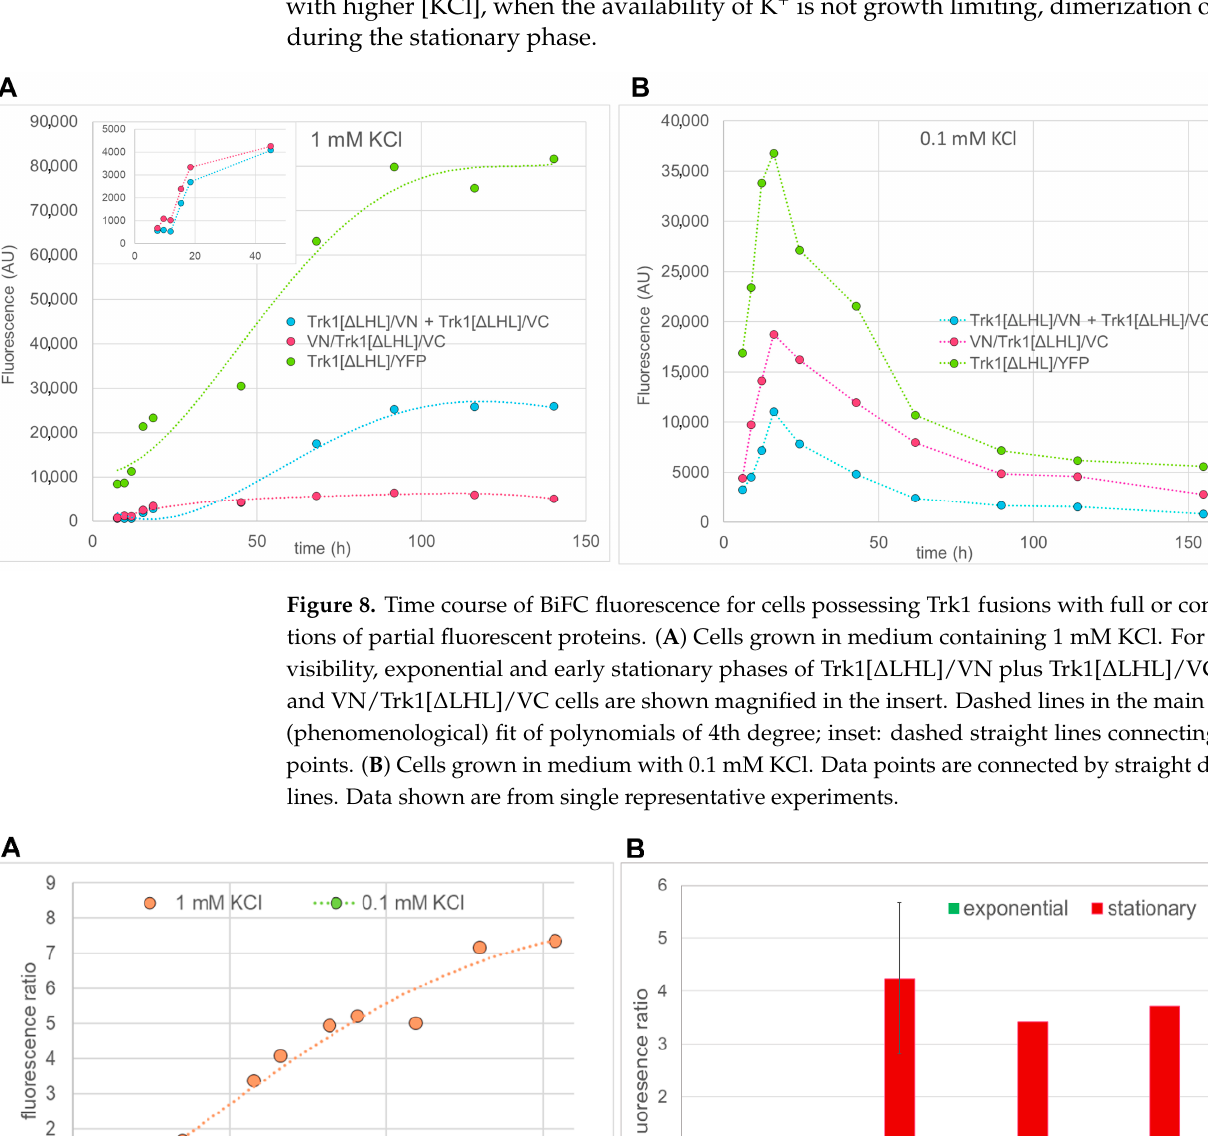
9 of 18 Figure 7. Quantification of BiFC . Representative BiFC fluorescence spectra of yeast cells grown in medium with 1 mM KCl and possessing the indicated Trk1[ Δ LHL] fusion proteins. Spectra were recorded in the late exponential phase (OD ~ 2.5; growth time: 14 h). The spectra of Trk1[ Δ LHL]/VN + Trk1[ Δ LHL]/VC, and VN/Trk1[ Δ LHL]/VC are magnified in the inset for better visibility. Sets of such spectra were taken with media containing different concentrations of KCl during exponential and stationary growth phases. To quantify fluorescence as one